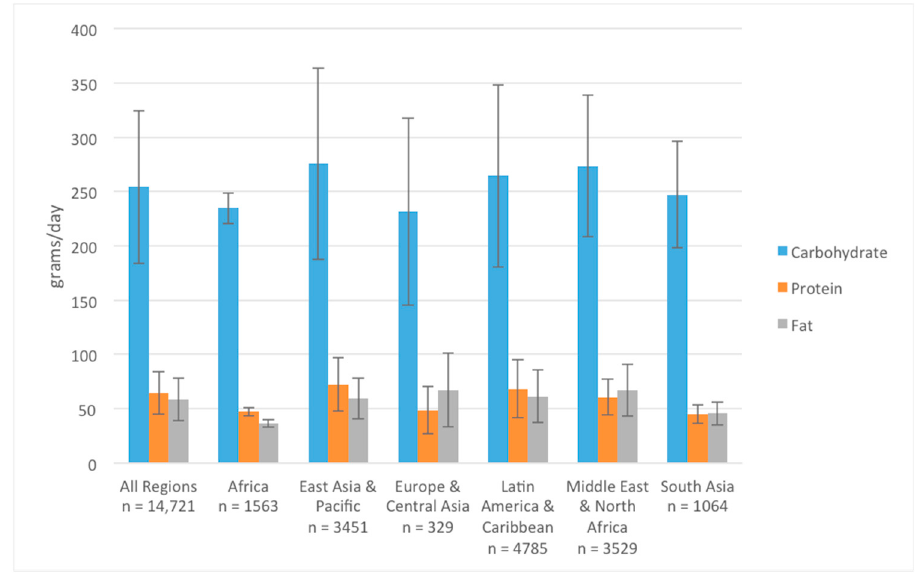
Figure 4. Adolescent girls’ macronutrient intake (g/day) across different geographical world regions.